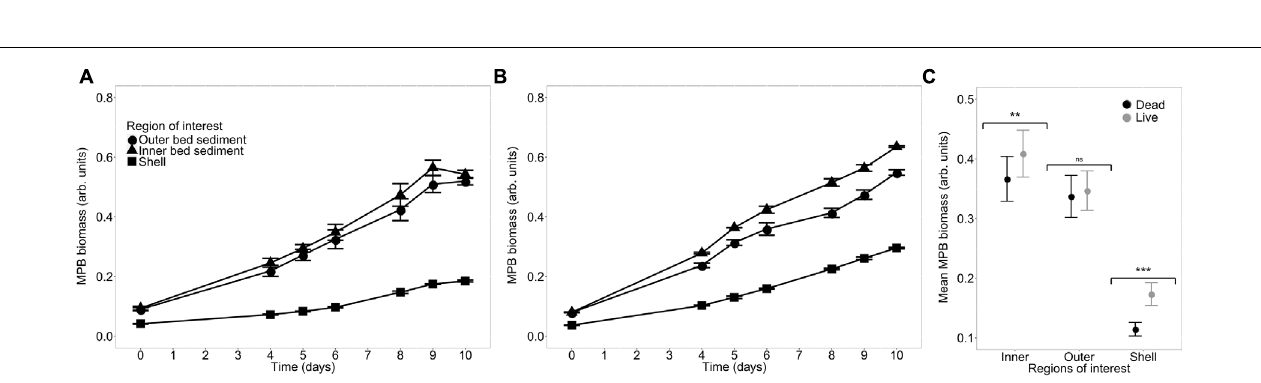
FIGURE 4 | Close-up images of sediment surface within the experimental Crepidula fornicata bed after 10 days. Shown are true color images with enhanced contrast (A,B) with corresponding sediment darkness maps (C,D) , and MPB biomass maps (E,F) in live and dead treatments.